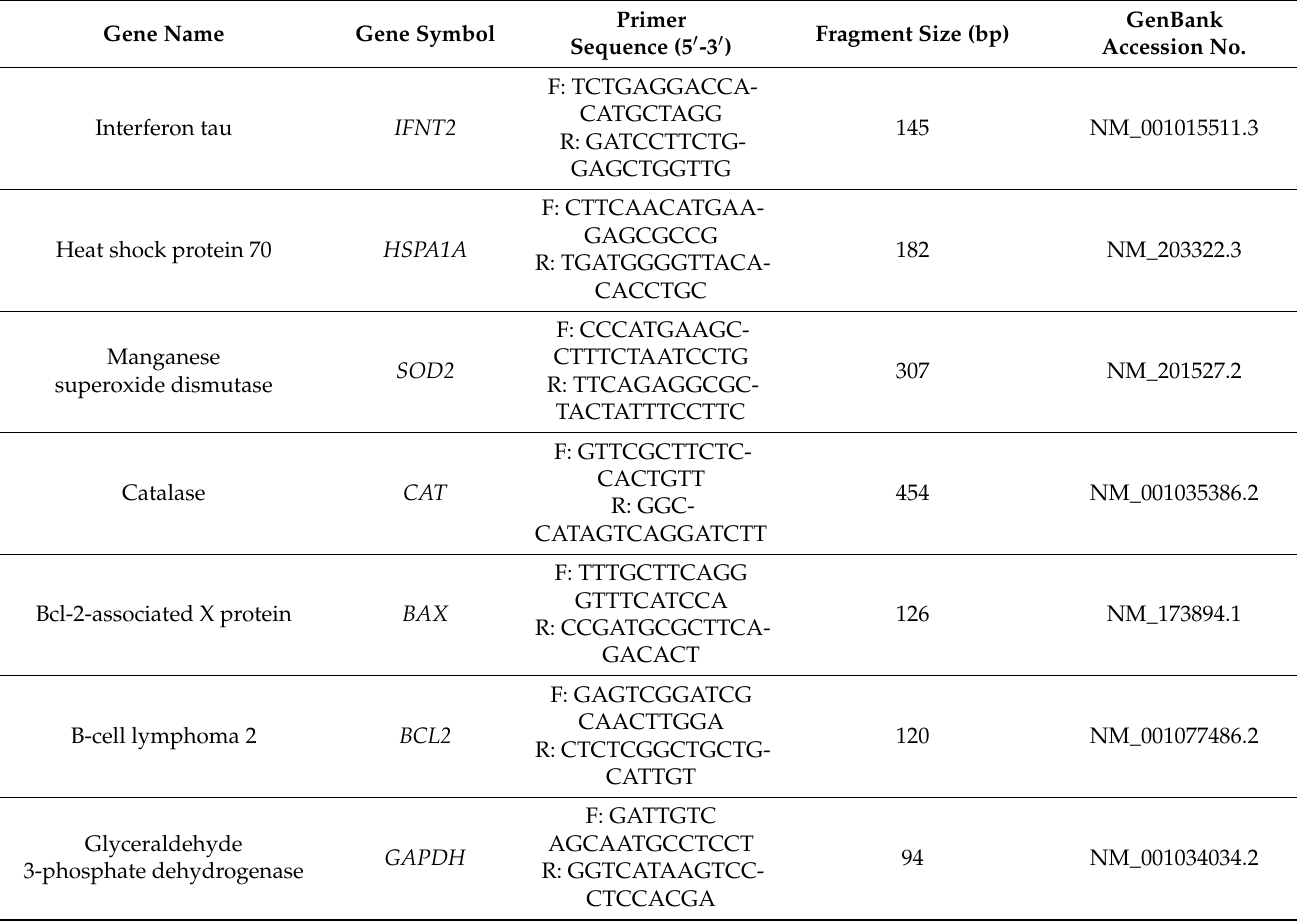
Table 1. Details of primers used for